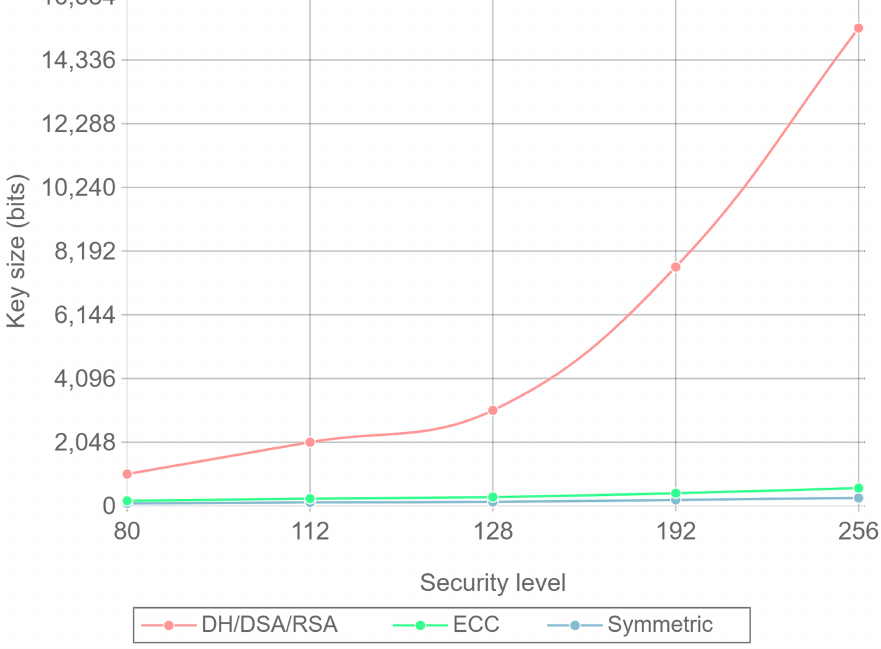
Figure 3. Key size needed for different security levels using symmetric, Rivest–Shamir–Adleman (RSA) and Elliptic Curve Cryptography (ECC)